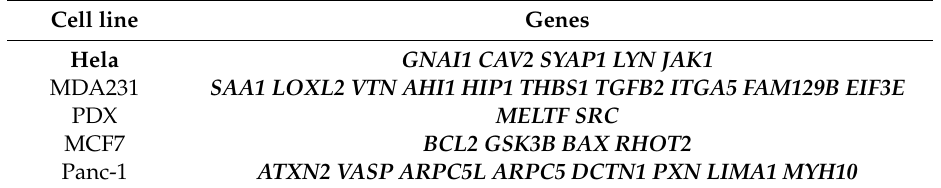
Table 2. Potential genes that may a ff ect the SiNR uptake.